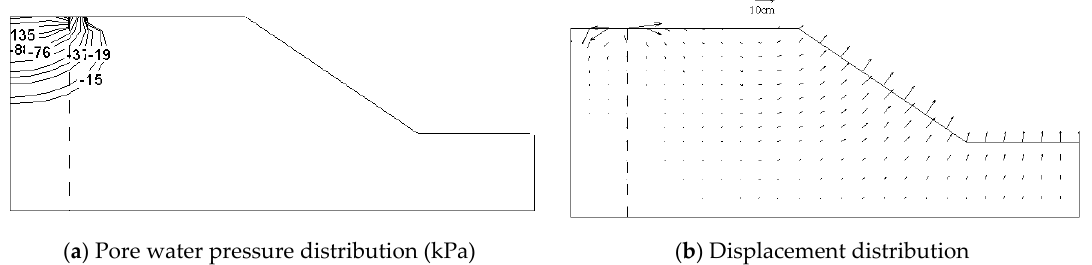
Figure 6. The distributions of pore water pressure and displacement at the end of evaporation when the crack was located 600 cm from the left edge of the soil slope.